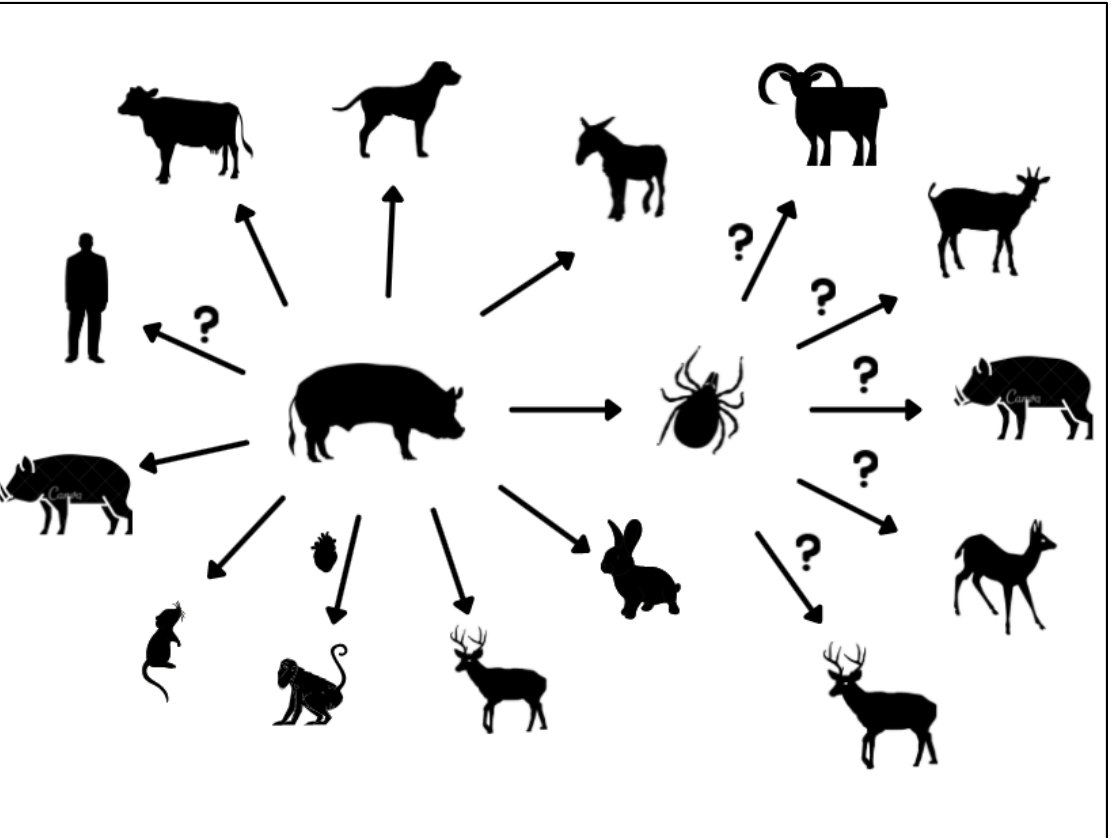
Figure 3. Possible cross-species transmission of PCV3. Arrows represent proven transmission of PCV3. Question marks represent possible but unconfirmed PCV3 transmission.